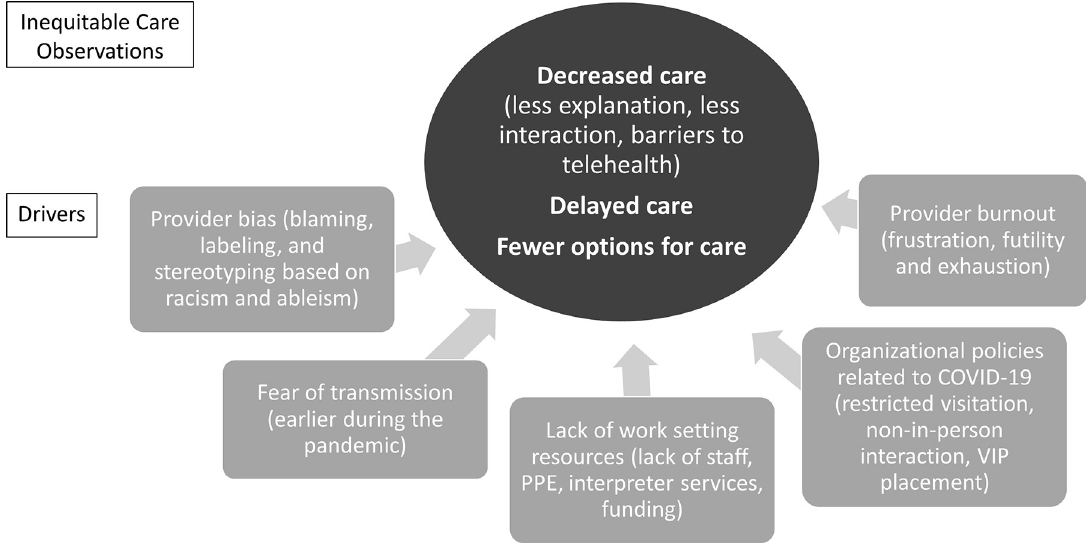
Fig 1. Model illustrating major